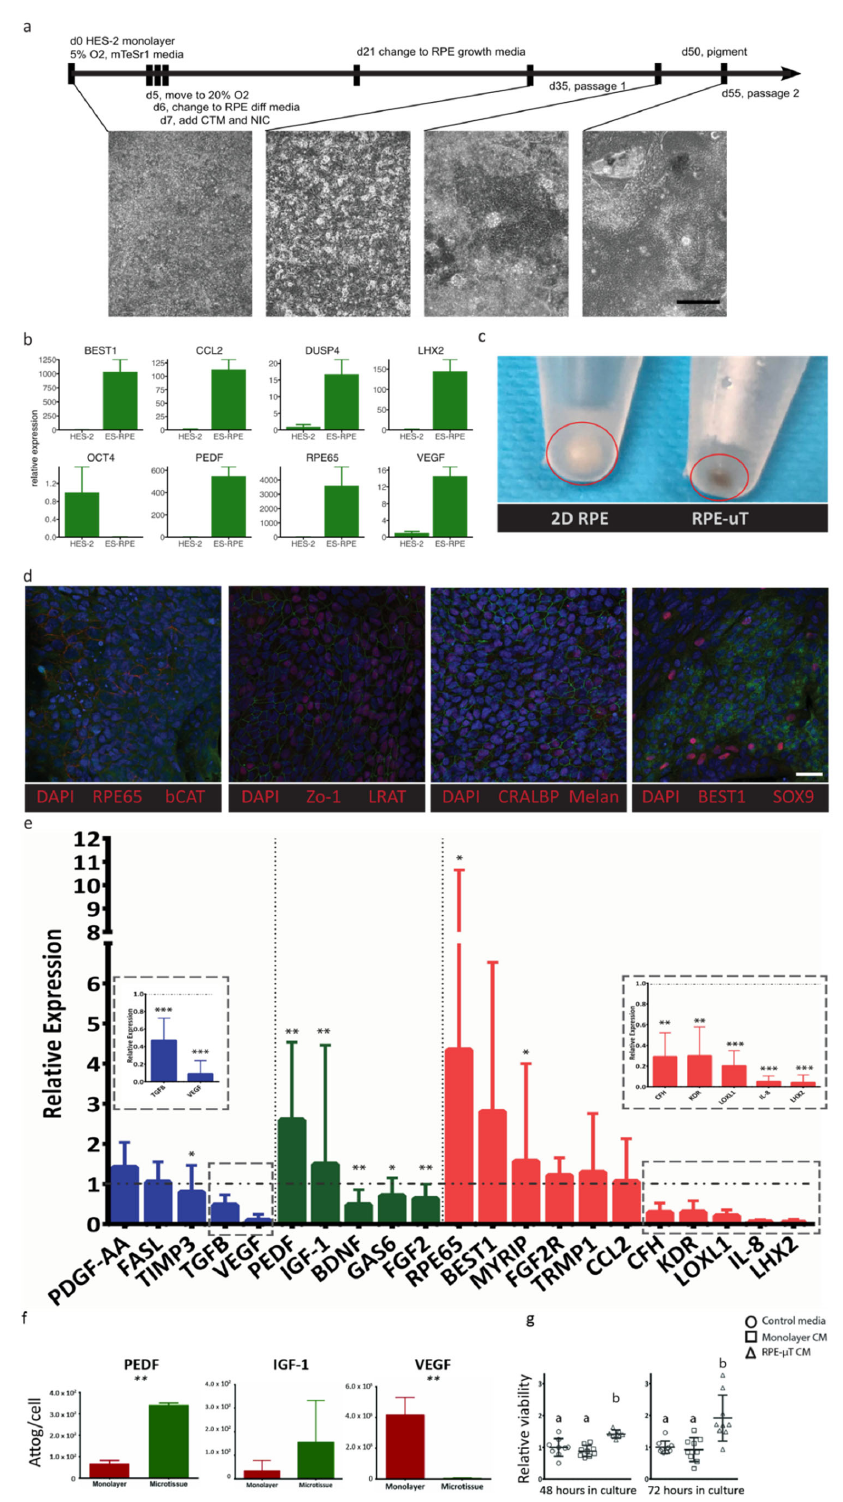
Figure 5. ES-derived RPE- µ Ts upregulate the expression of desirable photoreceptor trophic Figure 5. ES ‐ derived RPE ‐μ Ts upregulate the expression of desirable photoreceptor trophic factors. ( a ) Timeline outlining culture conditions and media components at various stages of differentiation. Scale bar = 400 μ m. ( b ) Relative mRNA